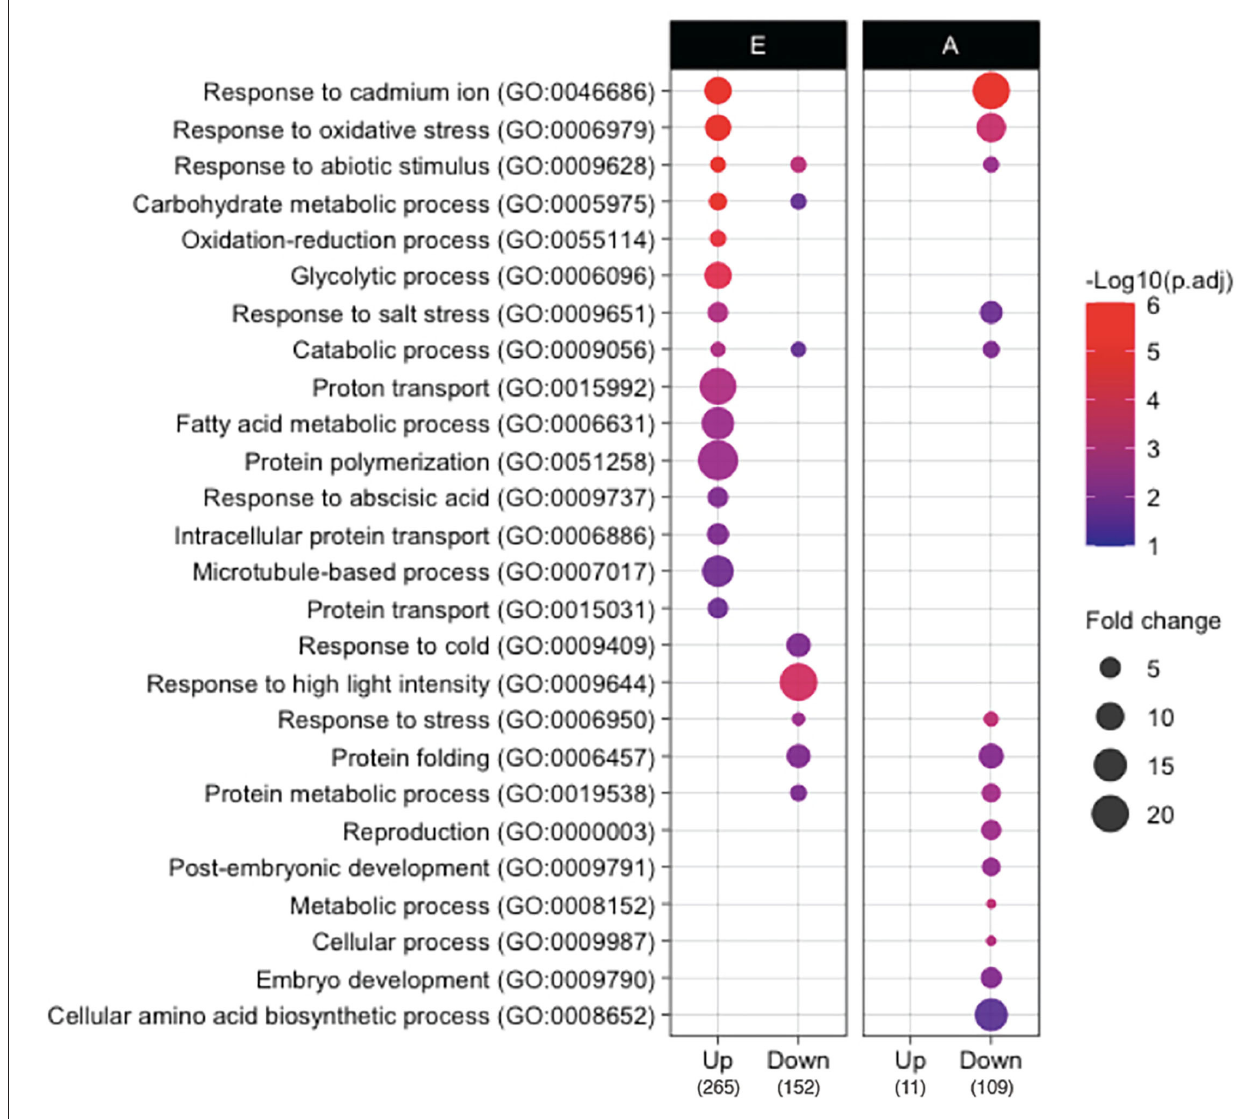
FIGURE 3 | Gene ontology (GO) comparison of proteins that accumulate differently in embryo and endosperm during germination. GO analysis was performed by using the CARMO (http://bioinfo.sibs.ac.cn/carmo/) for differentially accumulated proteins in the embryo (E) and endosperm (A) at 24 HAI compared to 0 HAI (the numbers in bottom brackets of the panel indicate the number of up or down-accumulated proteins). Significant GO terms (adjusted p -value < 0.05, Benjamini–Hochberg correction) in “biological process” were obtained from each protein group except for up-accumulated proteins in endosperm since too few proteins ( n = 11) were up-accumulated in the endosperm. Fold change represents fold enrichment of genes with the given term as compared to ones in the rice genome